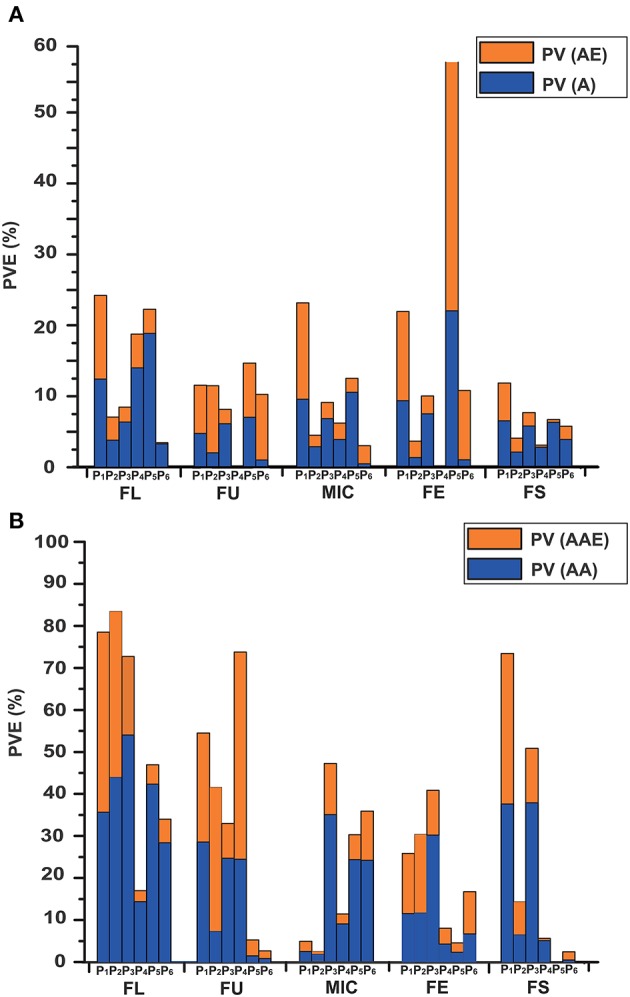
Phenotypic variance explained by the m-QTLs and e-QTLs in the IF2, HSBCF1, MARBCF1, IF2MPH, HSBCF1MPH, and MARBCF1MPH datasets for fiber quality traits. (A) Phenotypic variance explained by m-QTLs. PV, the phenotypic variance that the total effects explained; PV (A), the phenotypic variation that the main effects explained; PV (AE), the phenotypic variation that the environmental interaction effects explained. (B) Phenotypic variance explained by the e-QTLs. PV, the phenotypic variation that the total epistasis effects explained; PV (AA), the phenotypic variation that the main epistasis effects explained; PV (AAE), the phenotypic variation that the environmental interaction effects explained. P1, IF2; P2, HSBCF1; P3, MARBCF1; P4, IF2MPH; P5, HSBCF1MPH; P6, MARBCF1MPH.